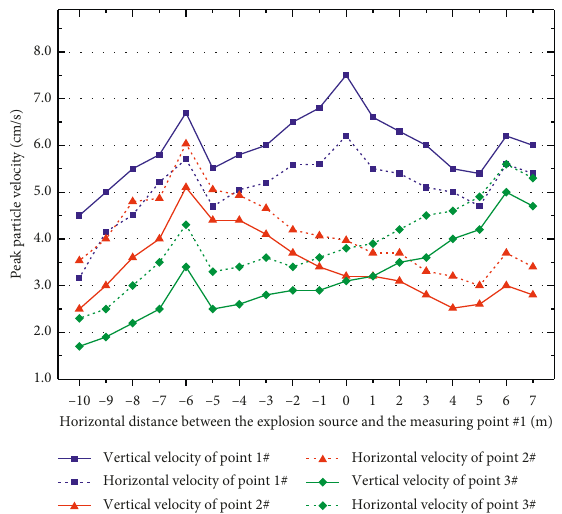
Figure 13: Trends in PPV of #1, #2, and #3 measuring